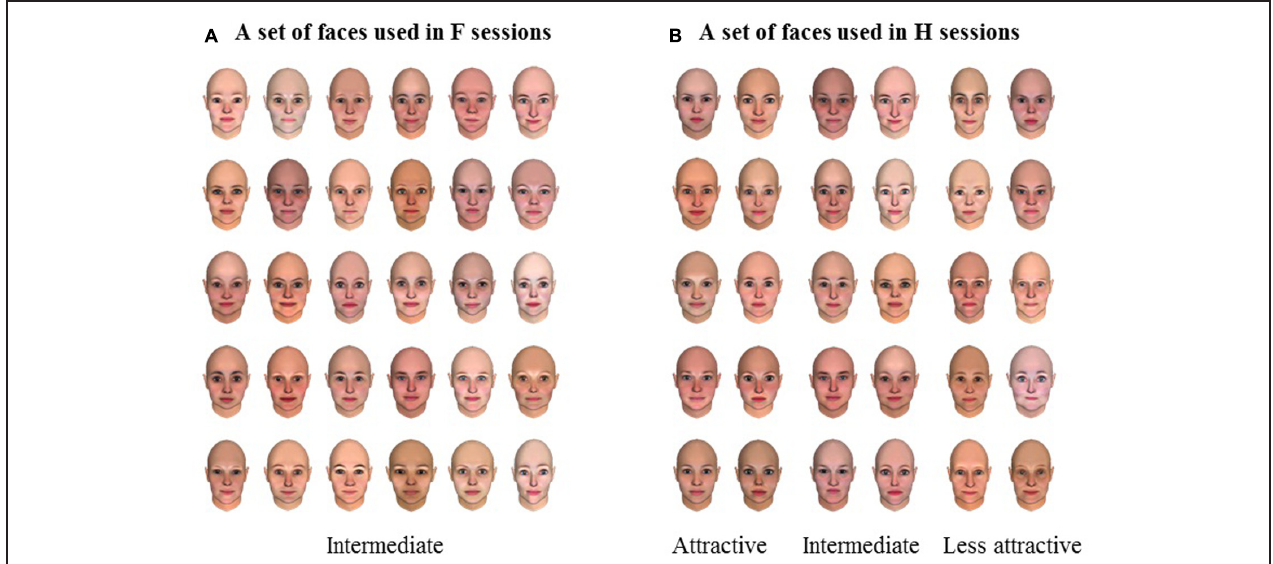
FIGURE 6 | Sets of faces used in F sessions (A) and H sessions (B) of Experiment 2. In this figure the sets of faces only that were used in Experiment 2 are shown. The main task was face attractiveness rating in F sessions, while the main task was hair attractiveness rating in H sessions. The list of sessions is shown in